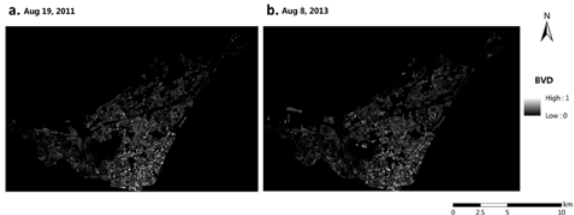
Figure 4. BVD images with the cell size of 60 meters derived